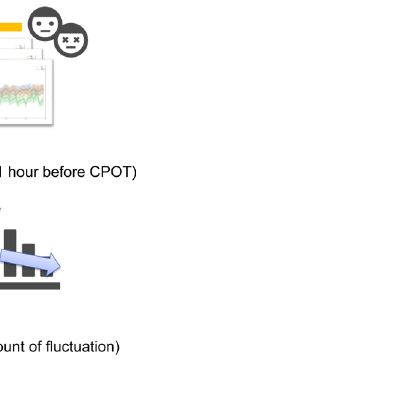
Figure 2. Procedure for creating training